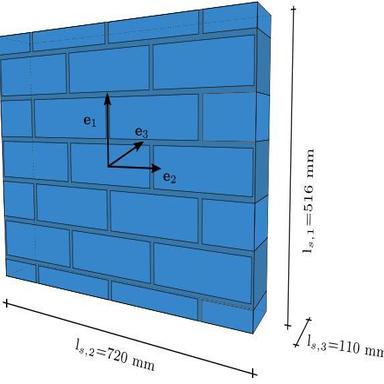
Numerically-justified experimental specimen.